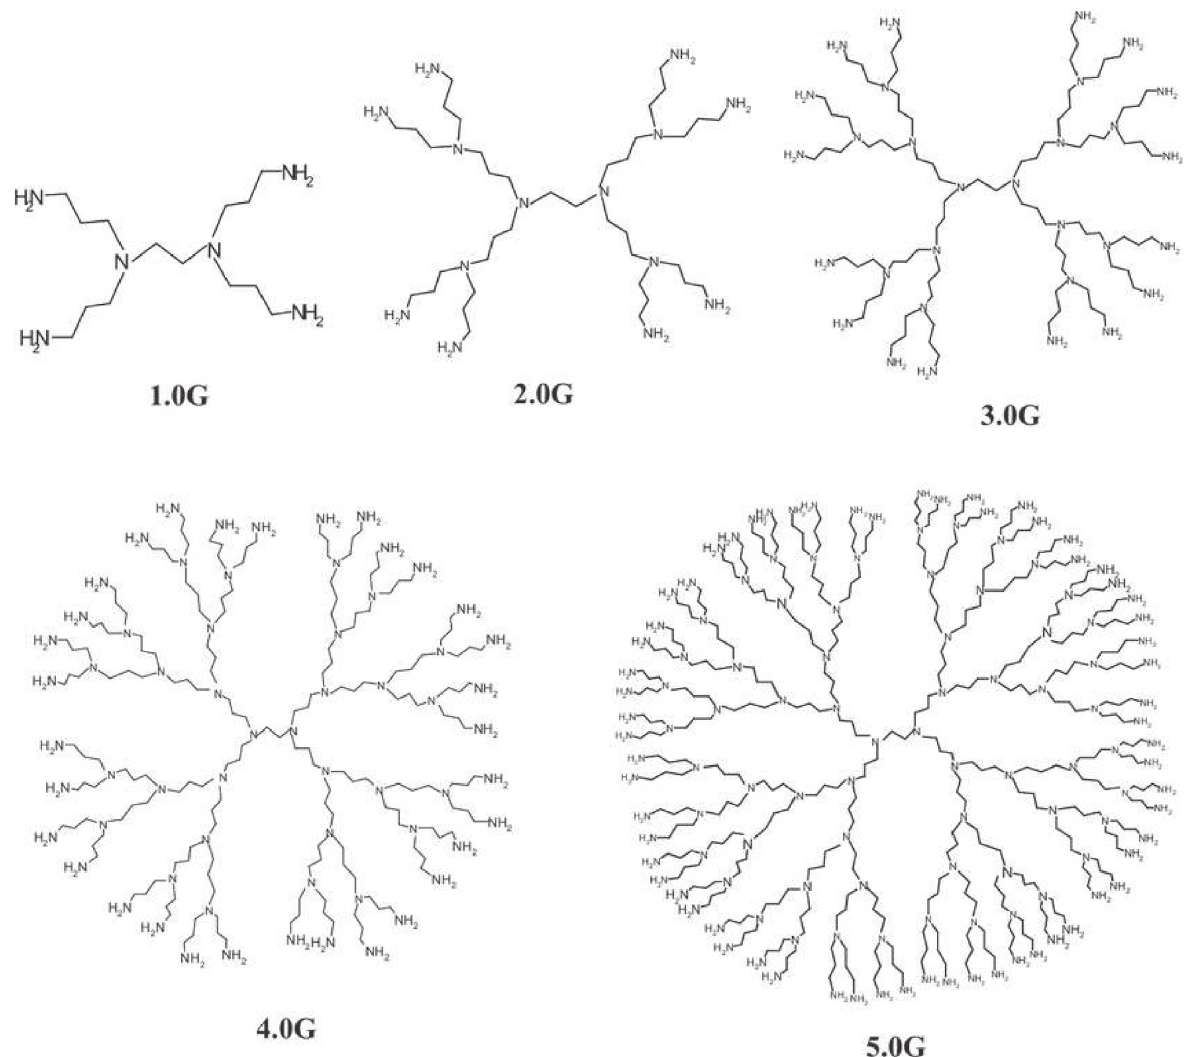
Figure 3: Chemical structural formula of PPIO